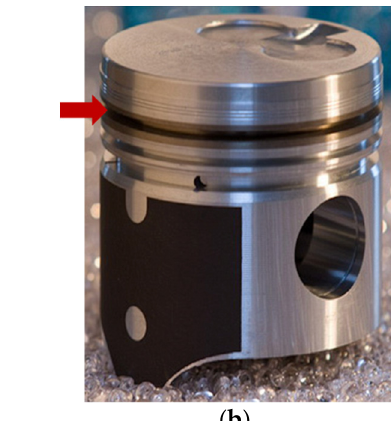
Table 1. Chemical composition 1 of EN AC 48000 (AlSi12CuNiMg) commercial alloy * and modified by adding 1% Mg **.